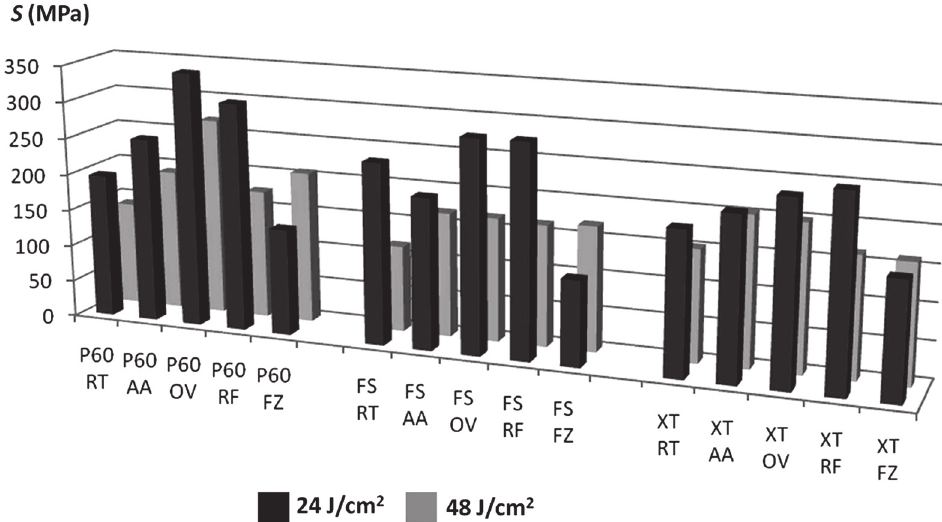
Figure 3- Graphic of flexural strength (MPa) considering all factors: I. Composites: Filtek P60 (P60), Filtek Silorane (FS) and Filtek Z350XT (XT); II. Syringe storage conditions: Room Temperature (RT), Accelerated aging (AA), Oven 24 h (OV), Refrigerator 24 h (RF), Freezer 24 h (FZ); III. Energy doses: 24 J/cm 2 and 48 J/cm